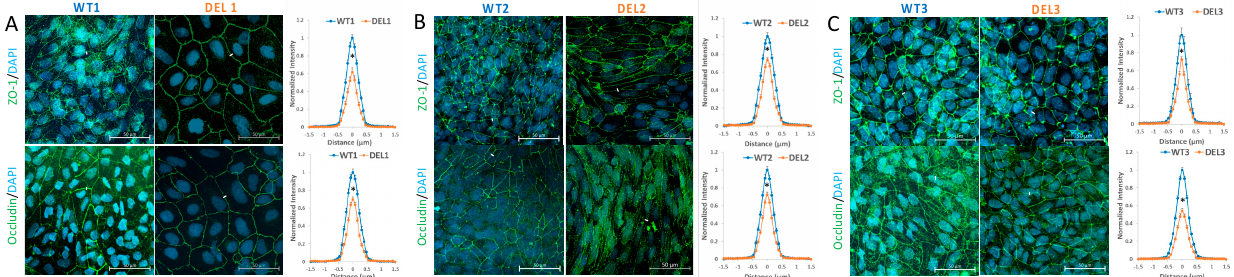
Figure 2. Comparison of junction proteins in the iBBB between control (WT) and 22q11.2DS-SCZ (DEL). Confocal images showing tight junction proteins (ZO-1 and occludin) at the iBBB for the control (left panel) and 22q11.2DS-SCZ (middle panel) from 3 paired iPSCs ( A – C ). The right panel shows the comparison of the normalized intensity profiles of ZO-1 and occludin labeling along a ~3 μ m line perpendicular to the EC junctions (white lines in the confocal images). n = 3 samples with 180–270 junctions (720–1080 perpendicular lines) analyzed for each case. * p < 0.05.